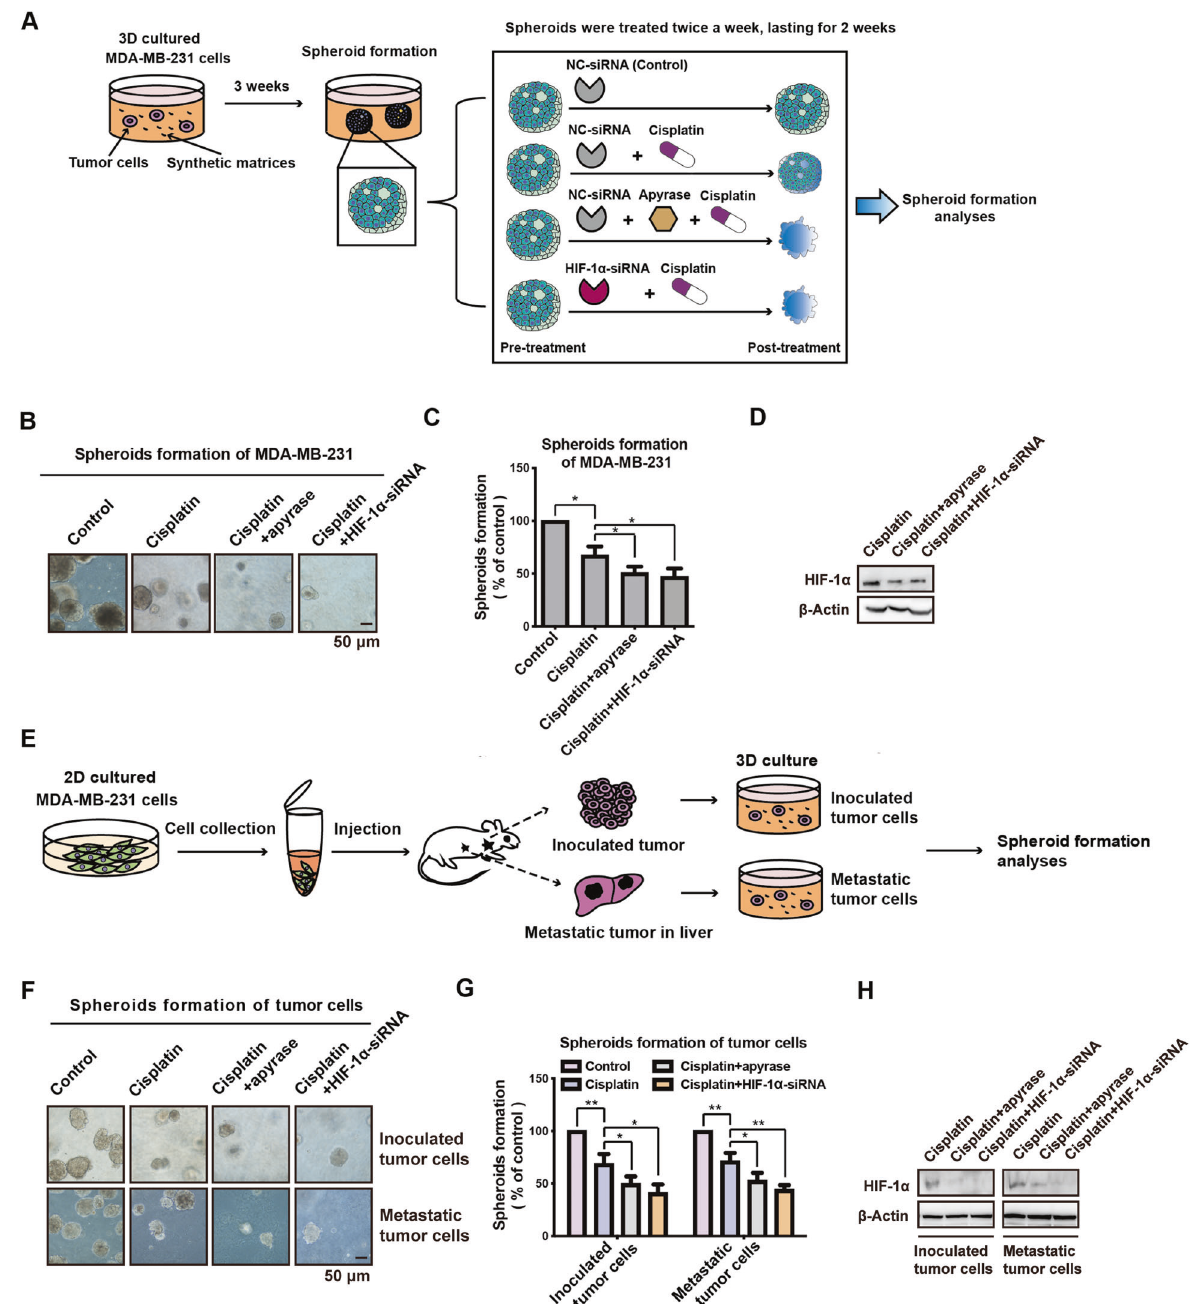
Fig. 5 ATP-HIF-1 α signaling mediates spheroid chemoresistance in vitro. A The schema chart for spheroid formation in 3D culture. MDA- MB-231 cells grown in spheroid media were used to generate spheroids for 3 weeks, and then treated with apyrase (0.2 U/ml) or HIF-1 α -siRNA plus cisplatin (20 μ M) for additional 2 weeks. And spheroid formation assay was used to test drug sensitivity. B – D The spheroids were photographed ( B ) and calculated compared with the control group ( C ). Knockdown ef fi ciency of HIF-1 α was demonstrated via western blotting ( D ). E Schema chart for primary culture of inoculated- and metastatic-tumor cells and spheroid formation assay. F – H . Inoculated- and metastatic-tumor cells were used for spheroid formation assay, along with apyrase (0.2 U/ml) or HIF-1 α -siRNA, plus cisplatin (20 μ M) treatment. The spheroids were photographed ( F ) and spheroid formation ef fi ciency was calculated ( G ). Knockdown of HIF-1 α was detected by western blotting ( H ). Error bars represent means ± SD from triplicates. Data are representative of at least three independent experiments. * p < 0.05, ** p < 0.01, *** p < 0.001; ns, not signi fi